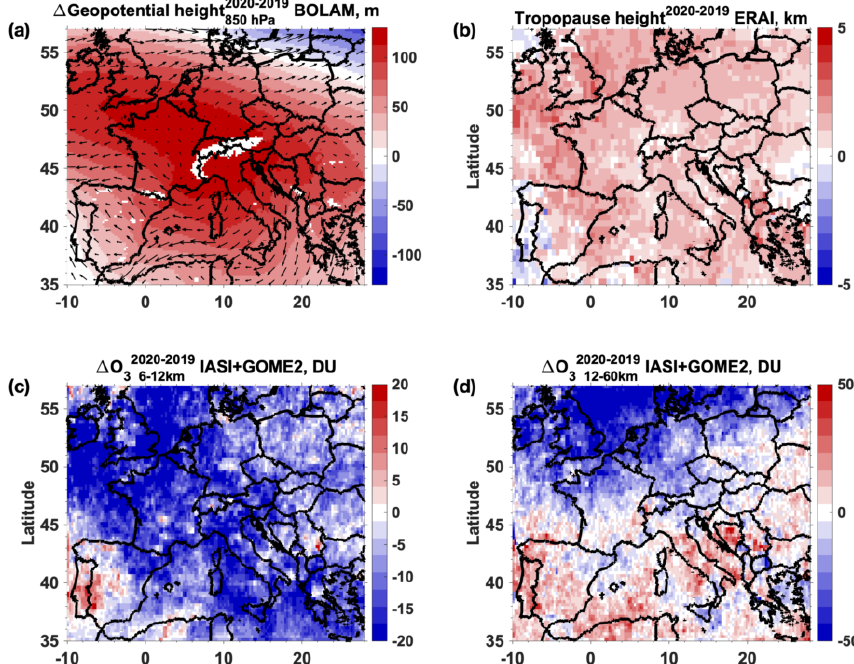
Figure 8. Changes in (a) geopotential height (m) and wind vectors at 850hPa from the BOLAM model, (b) tropopause heights (km) derived from vertical temperature profiles from ERA-Interim reanalyses from ECMWF, (c) ozone at 6–12km of altitude (DU), and (d) ozone at 12–60km of altitude (DU) retrieved from IASI + GOME2, averaged over the period 1–15 April 2020 with respect to the same period in 2019.